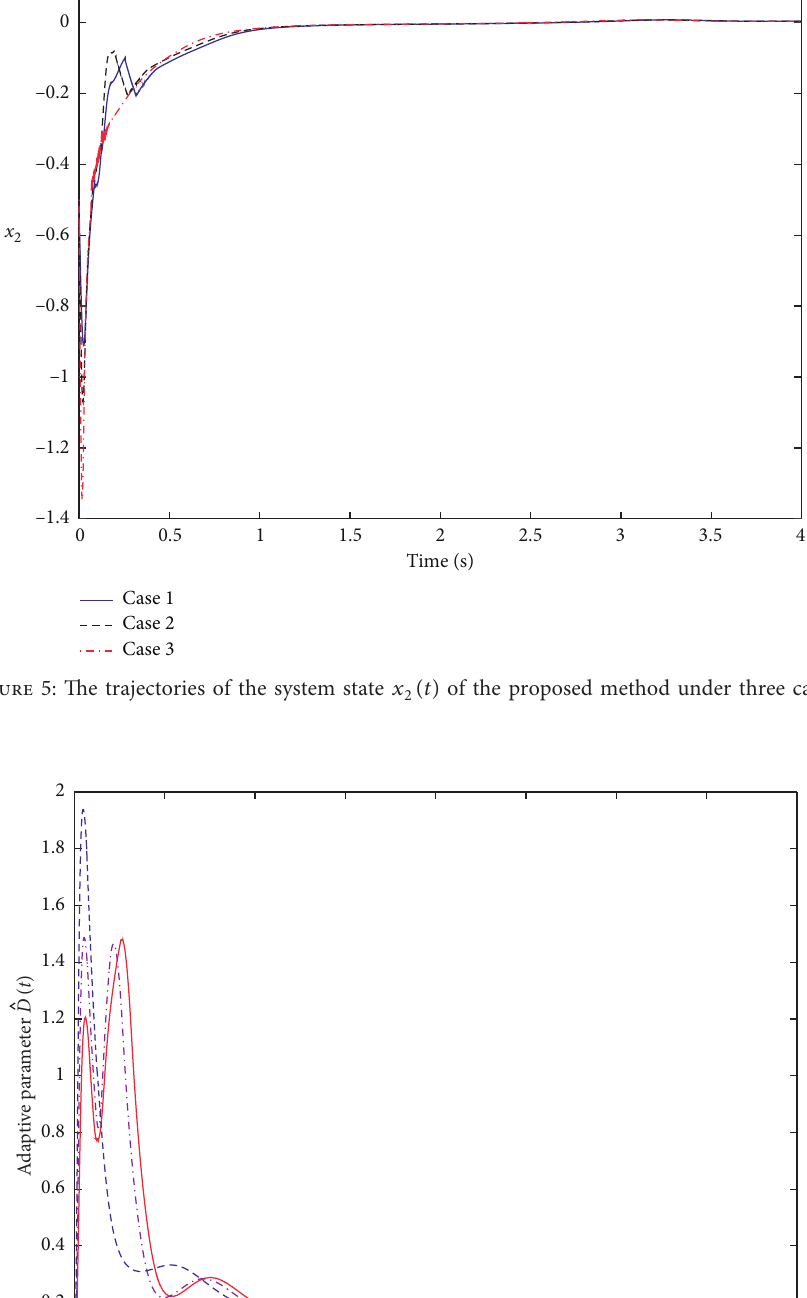
Figure 6: The trajectories of the system state 􏽢 D ( t ) of the proposed method under three cases.